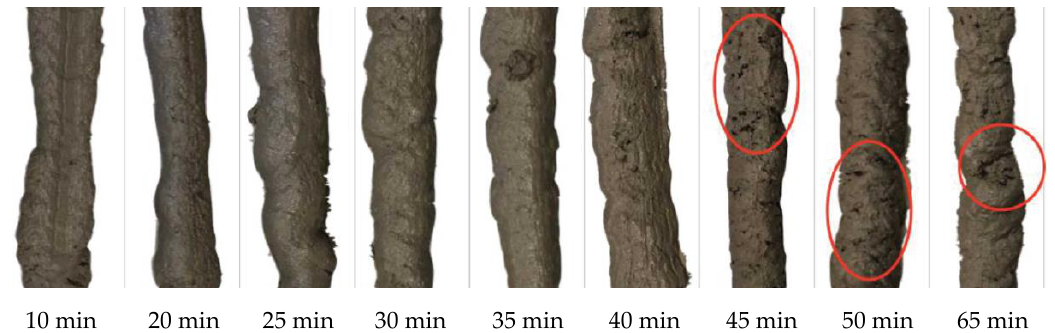
Figure 6. Quality of the single-layer extrusion: observation of the fluid consistency of extrusion from 10 min after mixing and crack occurrences from 45 min after mixing.